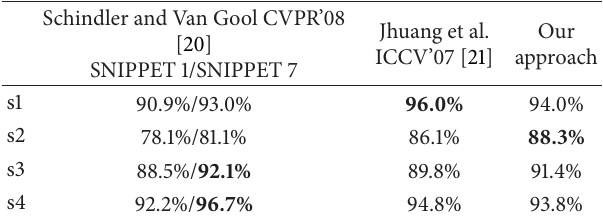
Table 2: Compared with other approaches on Weizmann dataset. Table 3: Experiment on KTH